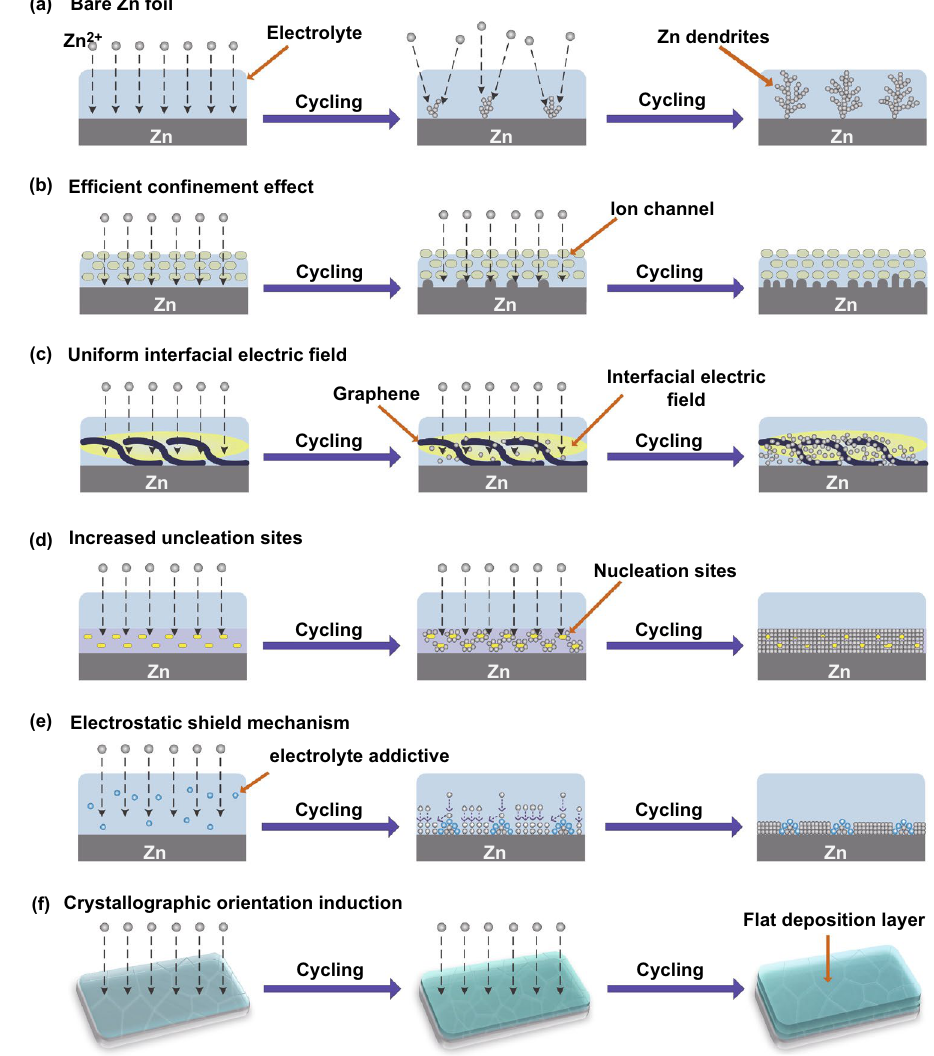
Fig. 2 a Schematic diagram of Zn dendrite formation on bare Zn. Schematic diagram for various dendrite suppression mechanisms on the coating layer. b Efficient confinement effect. c Uniform interfacial electric field. d Increased nucleation sites. e Electrostatic shield. f Crystallo- graphic orientation